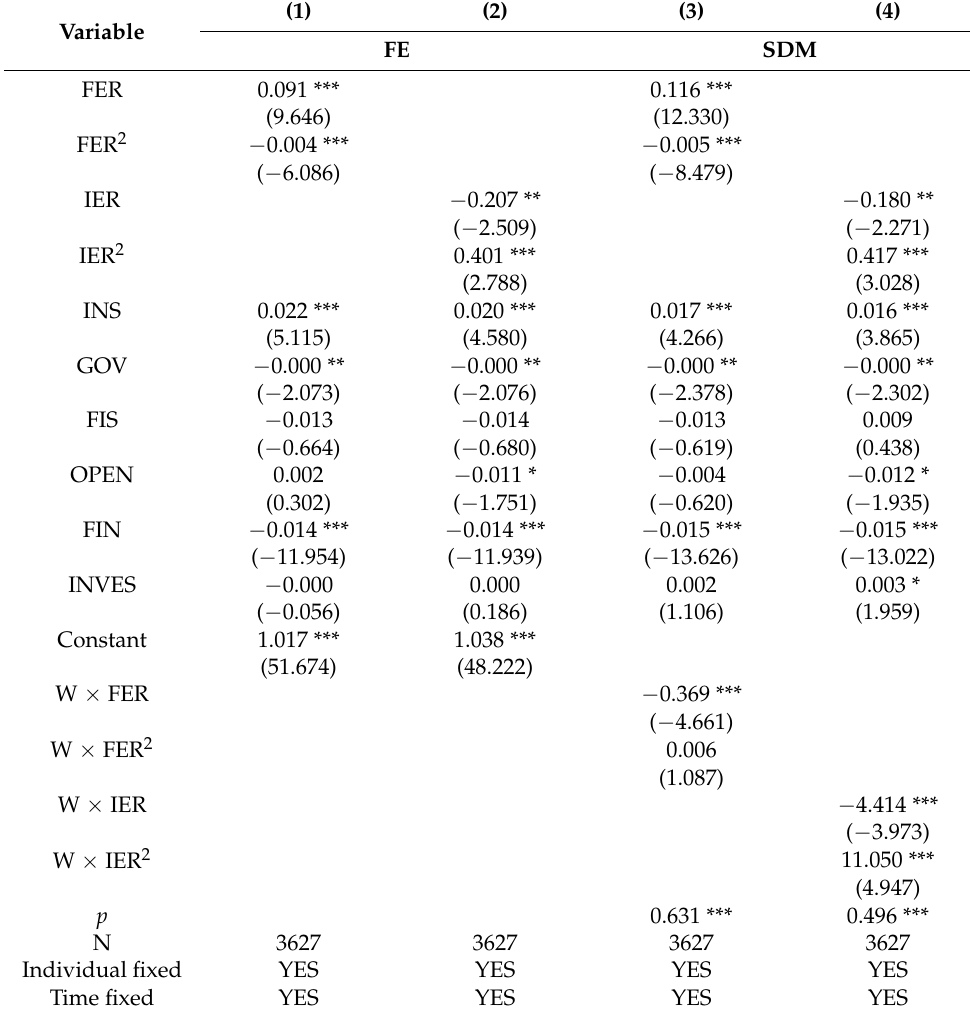
Table 5. Benchmark-regression